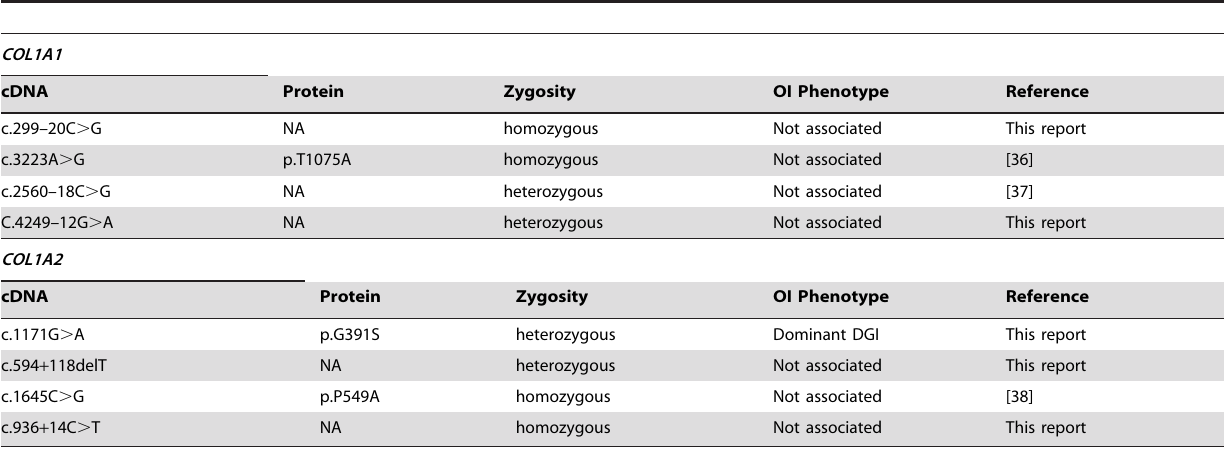
Table 2. Collagen ( COL1A1 and COL1A2 ) sequence variations identified in the proband.